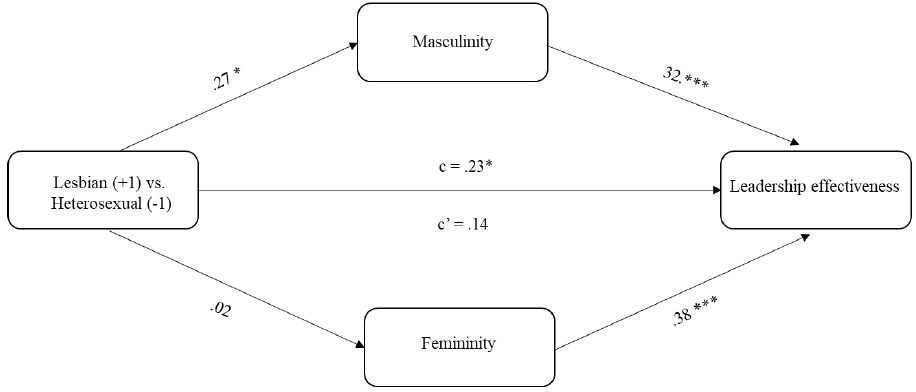
Figure 1. Proposed mediation model. Note . *** p < 0.001; * p < 0.05; Standardized coefficients are reported. C’= direct effect of sexual orientation on leadership effectiveness; c = total effect of sexual orientation on leadership effectiveness.